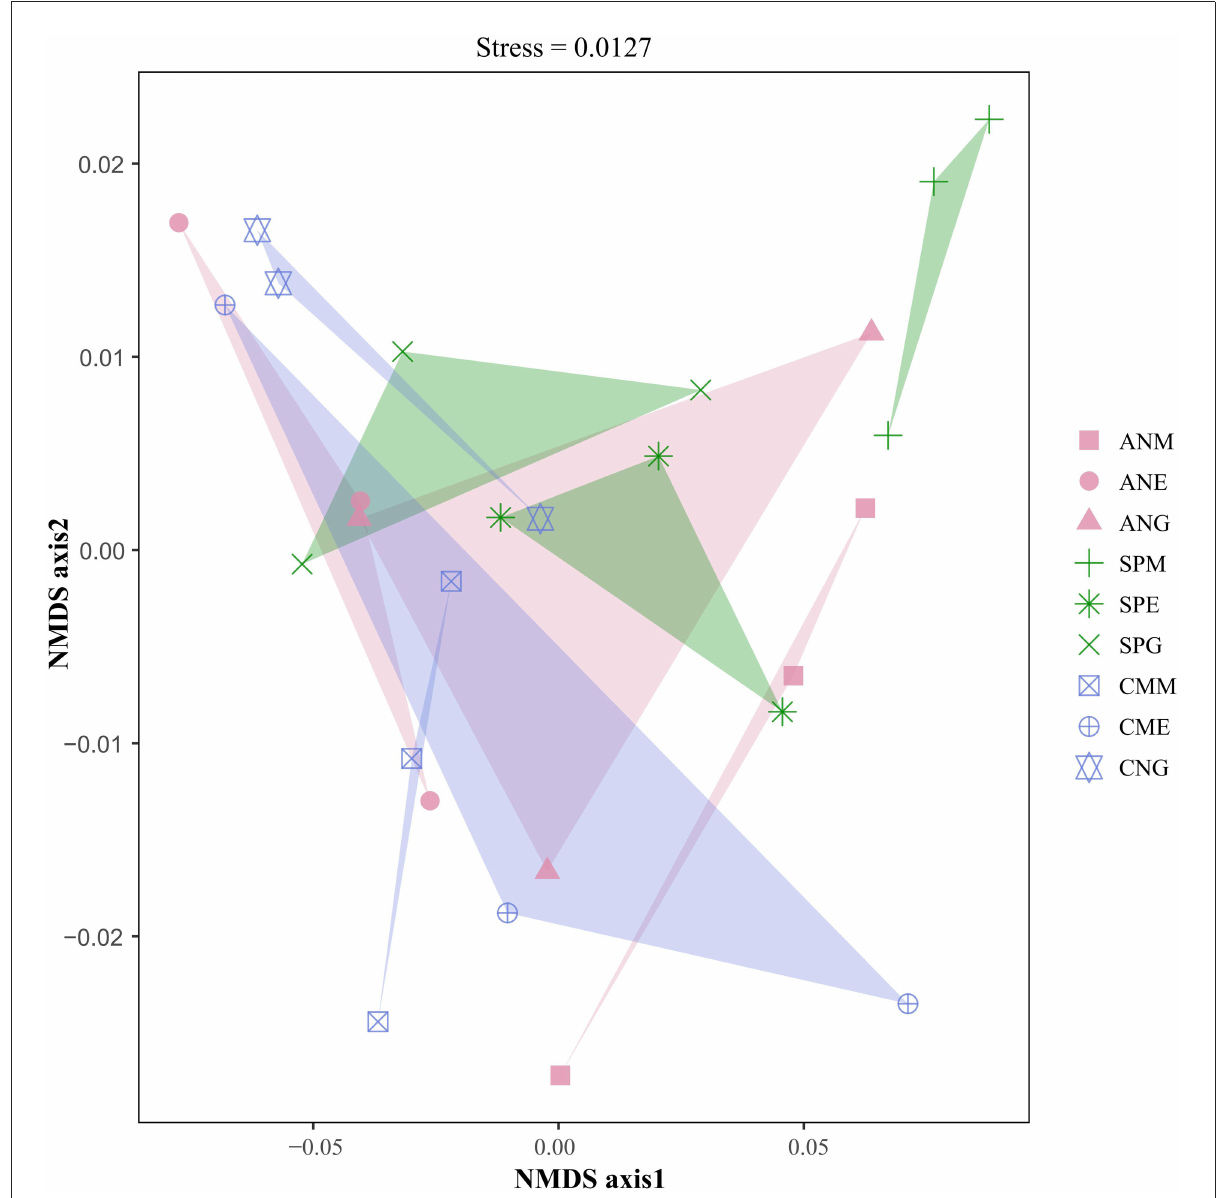
FIGURE6 Non-metric multidimensional scaling (NMDS) analysis of the rhizosphere soil microorganisms in alpine grasslands on the northern Tibetan alpine steppe. Different colors represent different